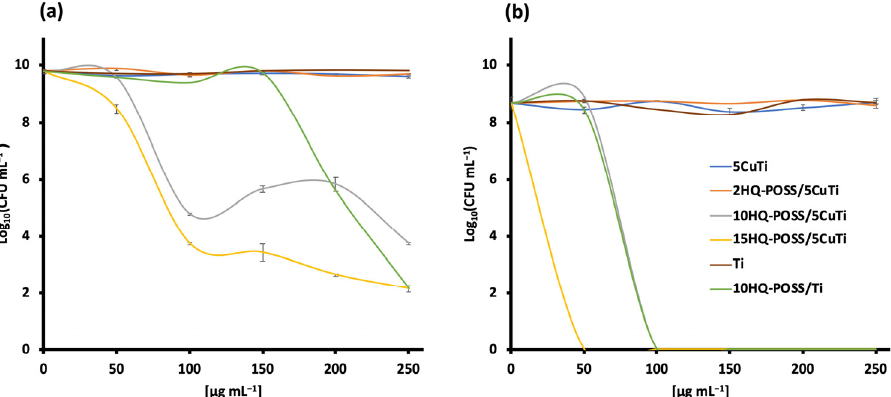
Figure 5. Kill curves of ( a ) Pseudomonas PS27 and ( b ) B. cereus in the presence of increasing concentra- tions of HQ-POSS, which was adsorbed onto CuTi and Ti